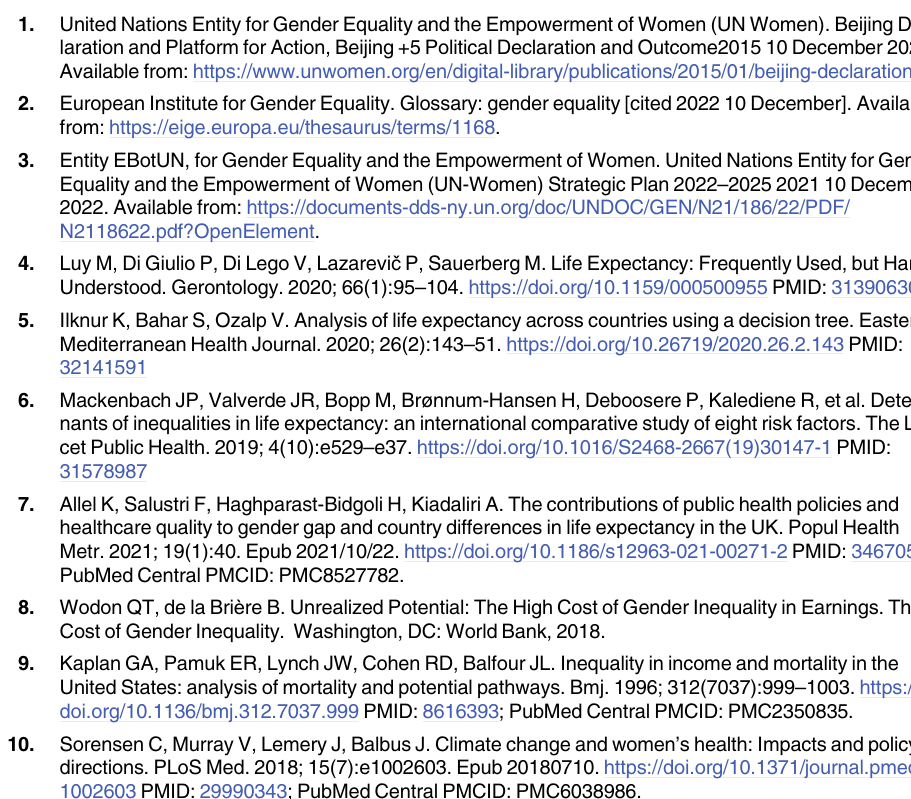
S8 Table. Cross-sectional association between the political subindex of the mGGGI and LE for women and men and gender gap in LE stratified by region in